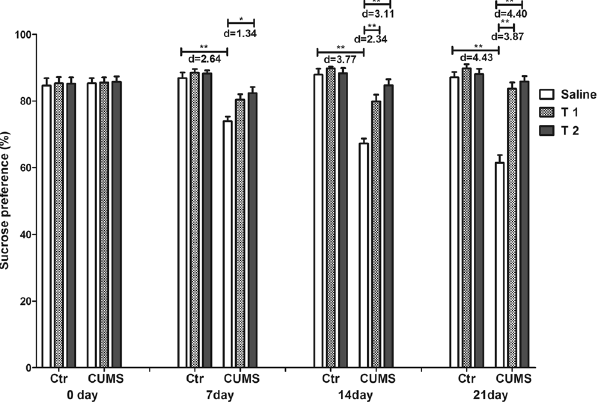
Figure 2. Effects of taurine on sucrose consumption in the SPT. Sucrose intake was recorded on days 0, 7, 14 and 21 of CUMS were applied. Ctr, control group; CUMS, CUMS group; Saline, i.p. saline; T1, i.p. 200 mg/ kg taurine; T2, i.p. 500 mg/kg taurine; All data are expressed as means ± SE and were analyzed by repeated measures ANOVA with group and time as factors followed by Bonferroni’s multiple comparisons post hoc test (n = 10). * P < 0.003 vs. CUMS group; ** P < 0.00067 vs. CUMS group. d means Cohen’s d, d = 0.20 was considered as small effect size, d = 0.50 was considered as medium effect size, d = 0.80 was considered as large effect